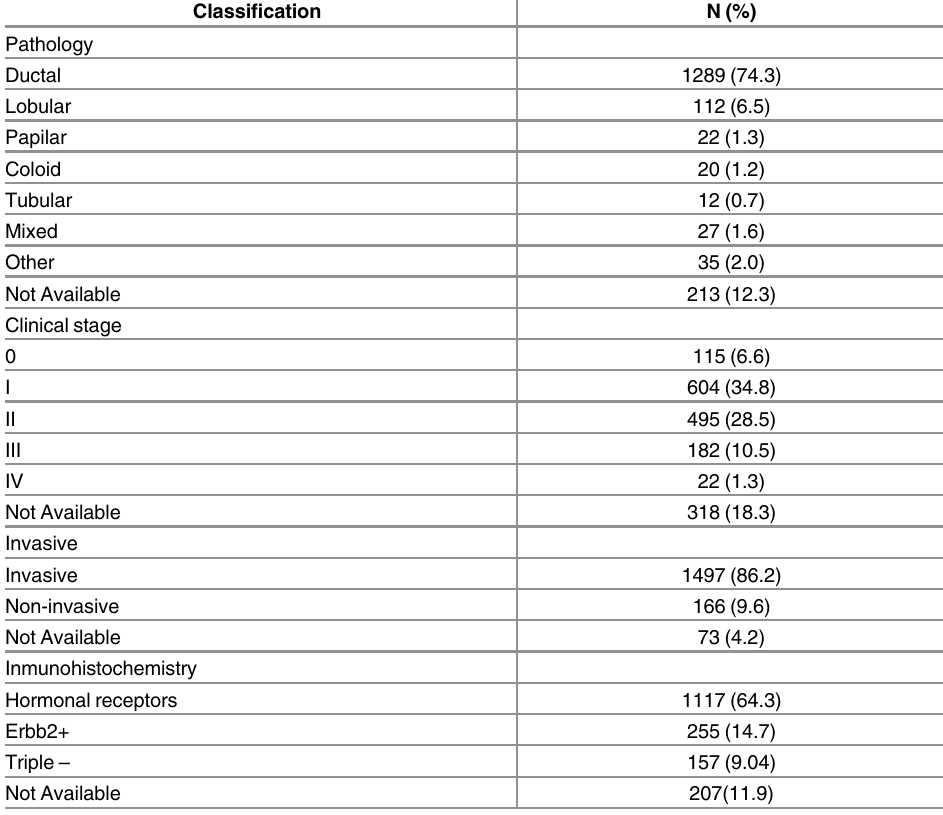
Table 2. Clinical and pathological characteristics of breast